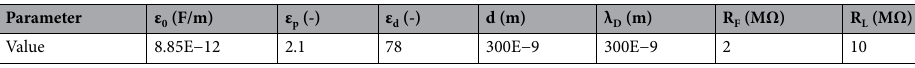
Table 1. Input parameters for EDLC model of pure water.